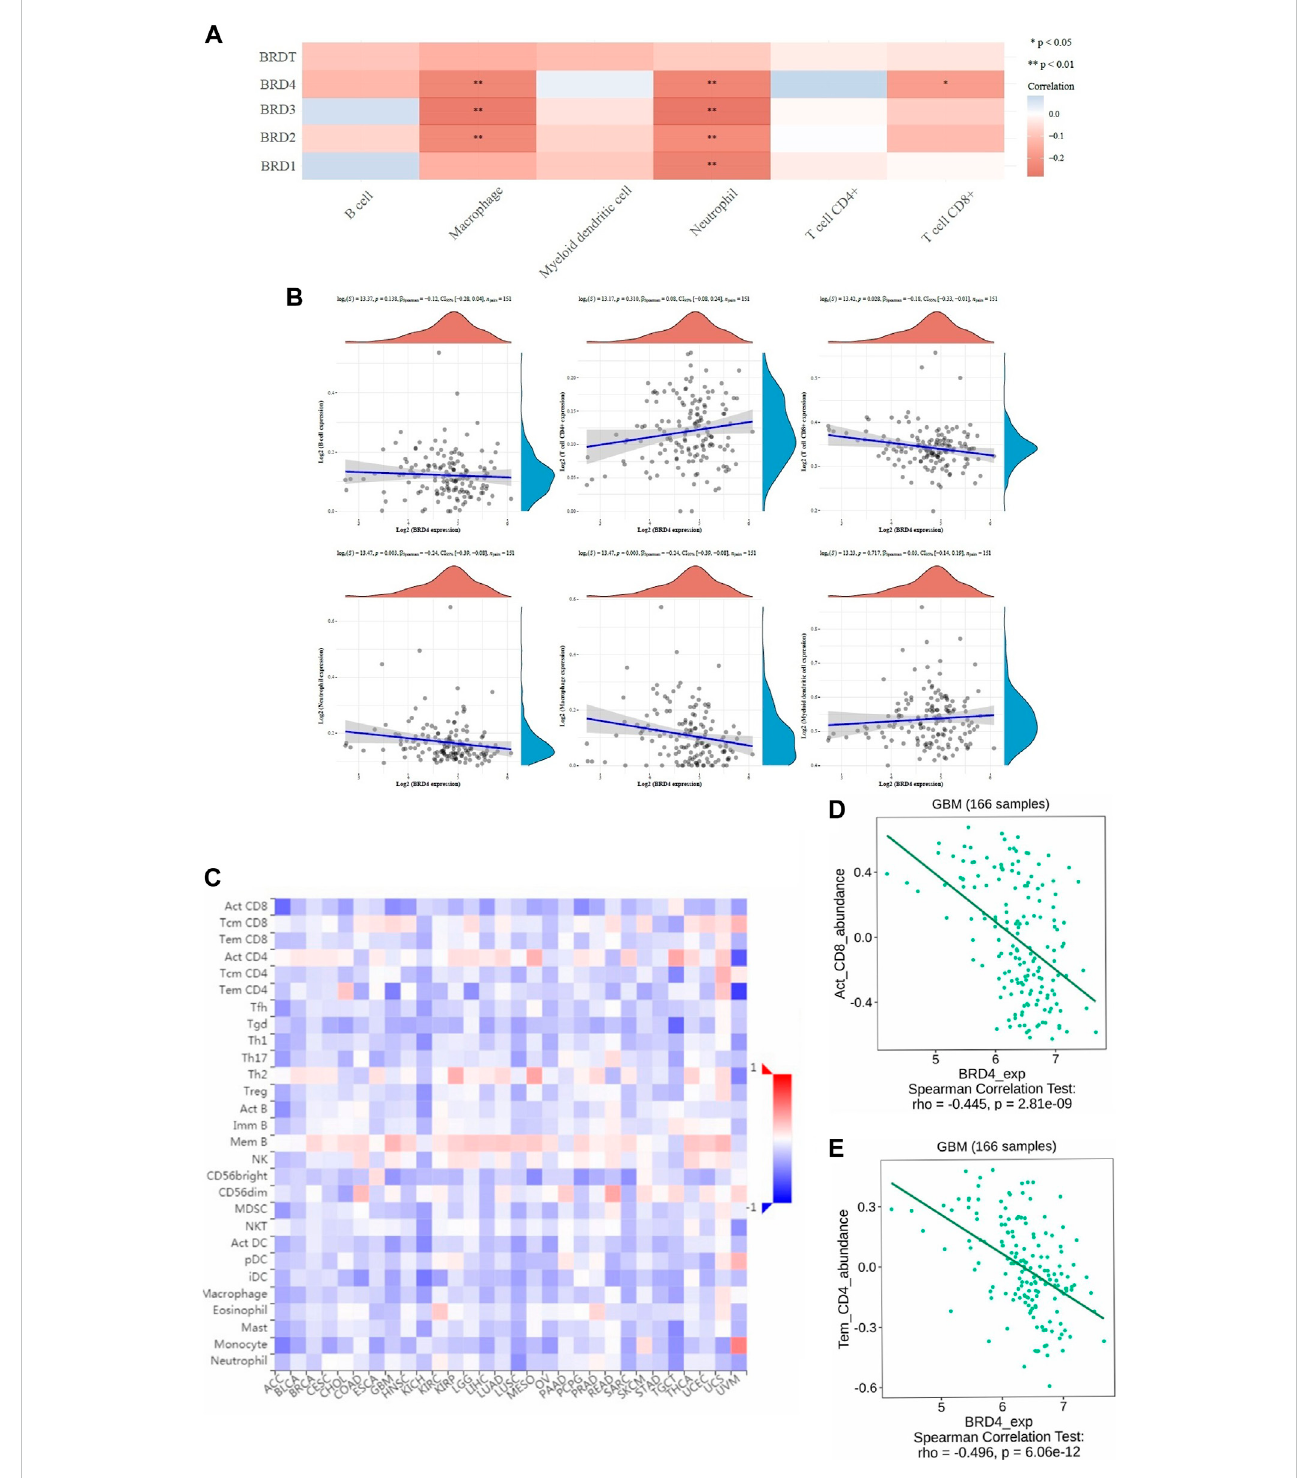
FIGURE 5 The correlation between BET genes expression and immune score was analyzed in TIMER and TISIDB database. (A) The heatmap of the correlation between BET genes and immune score in six types of immune cells. The different colors indicated different correlation coef fi cients (blue for positive correlation and red for negative correlation). (B) Relationships between the immune in fi ltration abundances and BRD4 expression in different immune cells (B-cell,CD4+T-cell,CD8+T-cell,neutrophils,macrophagesandmyeloiddendriticcells). (C) ThecorrelationsbetweenexpressionofBRD4and28types ofTILsacrosshumanheterogeneouscancers. (D) BRD4signi fi cantlynegativecorrelatedwithabundanceofactivatedCD8T-cell(Act_CD8;rho= − 0.445, p < 0.001). (E) BRD4 signi fi cantly negative correlated with abundance of effector memeory CD4 T-cell (Tem_CD4; rho = − 0.496, p < 0.001).